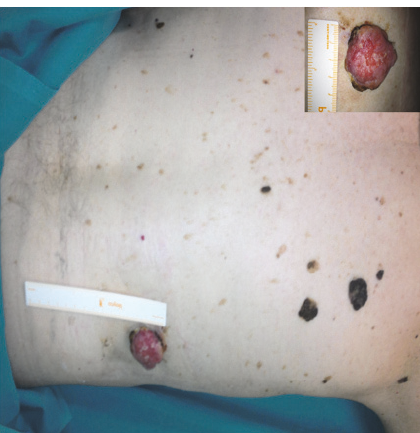
Figure 3: Immunostaining with ck-7 showed focal staining at eccrine poroma sites while areas of poroid hidradenoma were negative (ck-7 ×